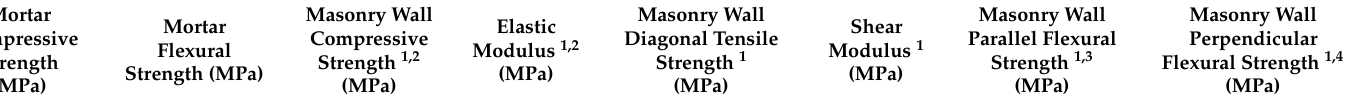
Table 3. Summary of material